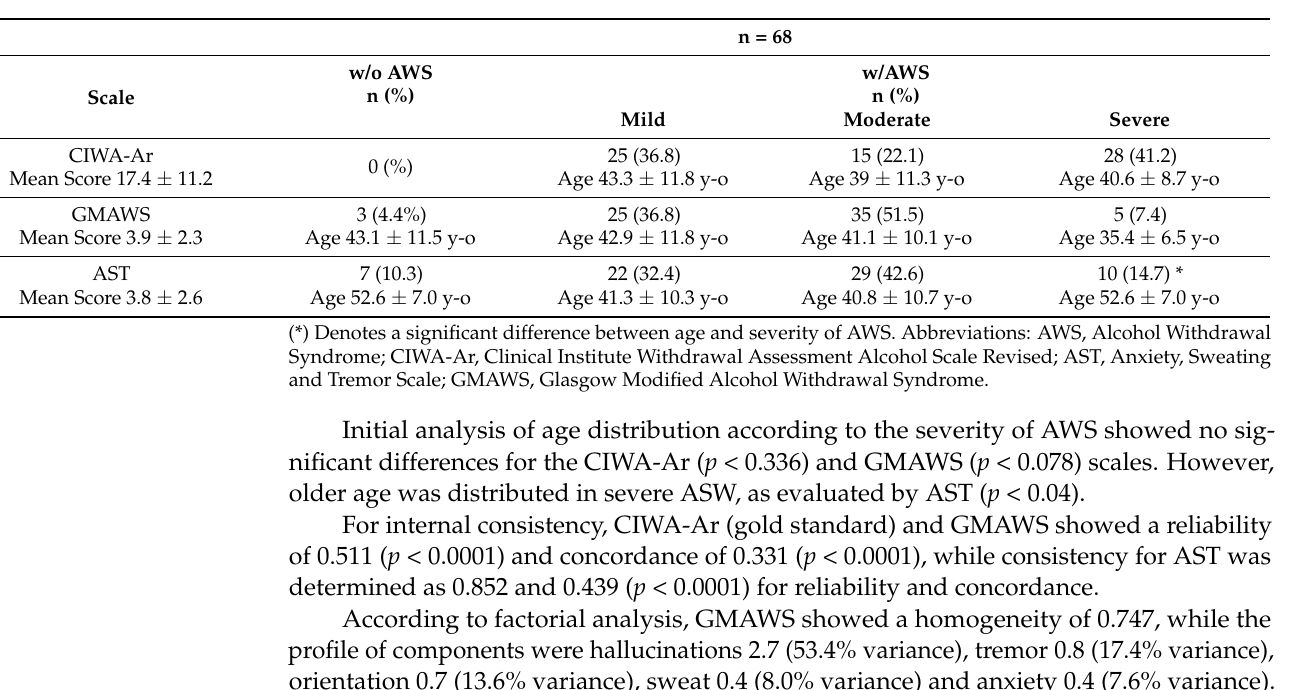
Table 2. Comparison of scales for